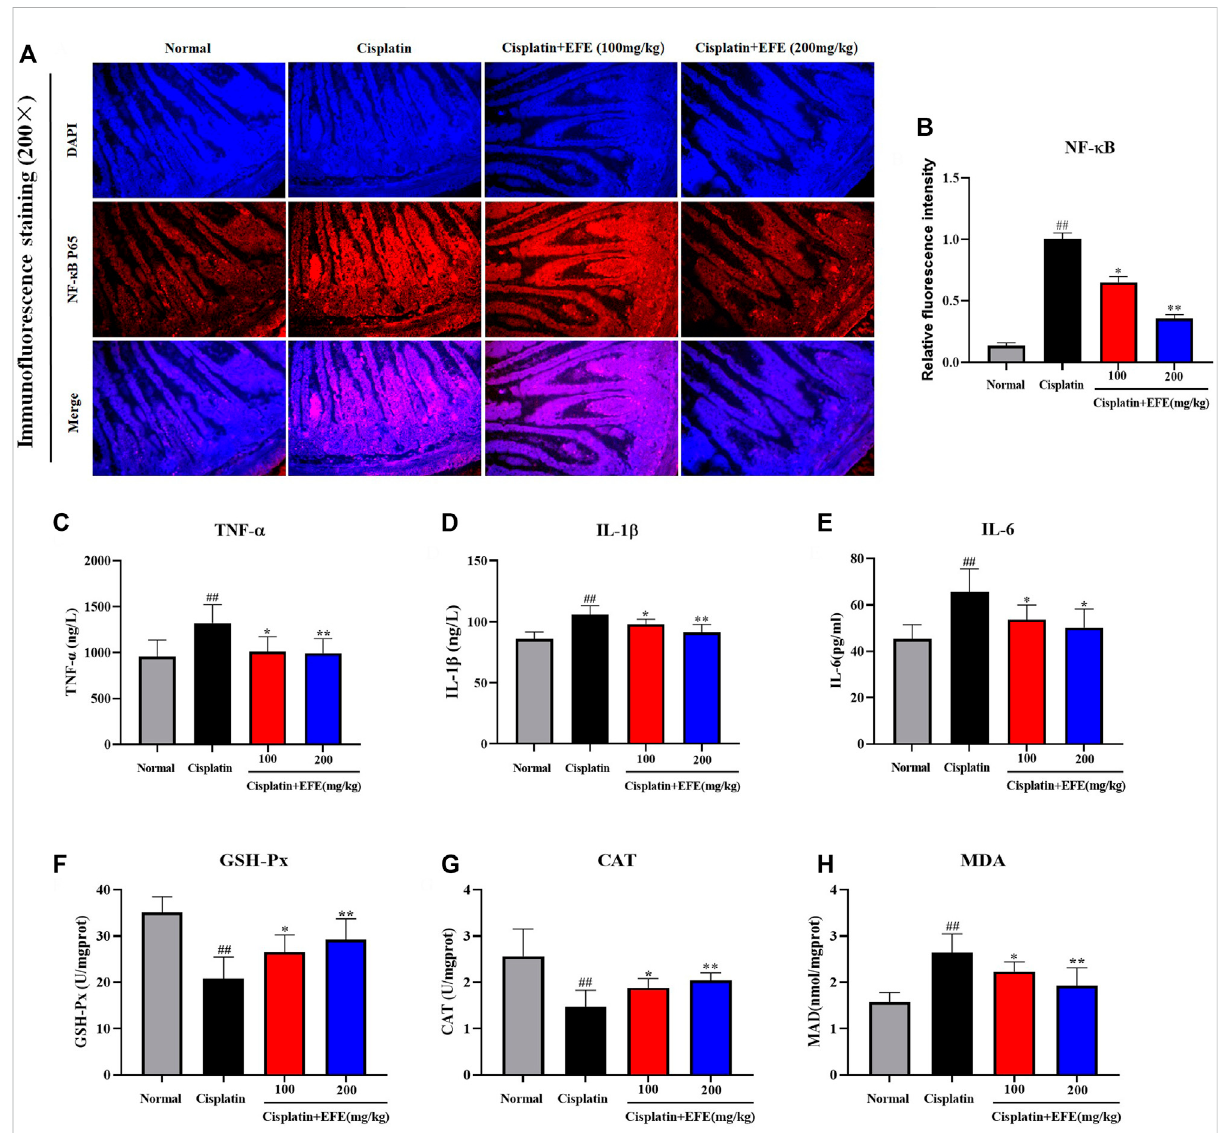
FIGURE 5 Effect of EFE on NF- κ B expression in mouse intestinal tissue (A) and quantitative analysis of fl uorescence intensity (B) ; Effect of EFE on serum TNF- α , IL-1 β , and IL-6 levels in mice (C – E) ; Effect of EFE on GSH-Px, CAT and MDA levels in mouse intestinal tissues (F – H) . Note: Values are expressed as Mean ± S.D., ( n = 10). ## p < 0.01 vs. normal group; * p < 0.05, ** p < 0.01 vs. model